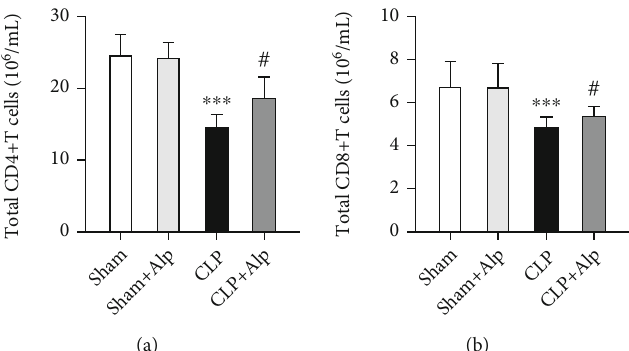
Figure 3: E ff ects of alpinetin on splenic T cells eight days after the procedure. After eight days, animals were sacri fi ced and the spleens were removed. Flow cytometry was then used to characterize the number of (a) total CD4 + T cells and (b) total CD8 + T cells in each group. Sham ( n = 10 ), sham+Alp ( n = 10 ), CLP ( n = 6 ), and CLP+Alp ( n = 8 ). Data are shown as mean ± SD . ∗∗∗ p < 0 : 001 , CLP vs. sham; # p < 0 : 05 , CLP- Alp vs.